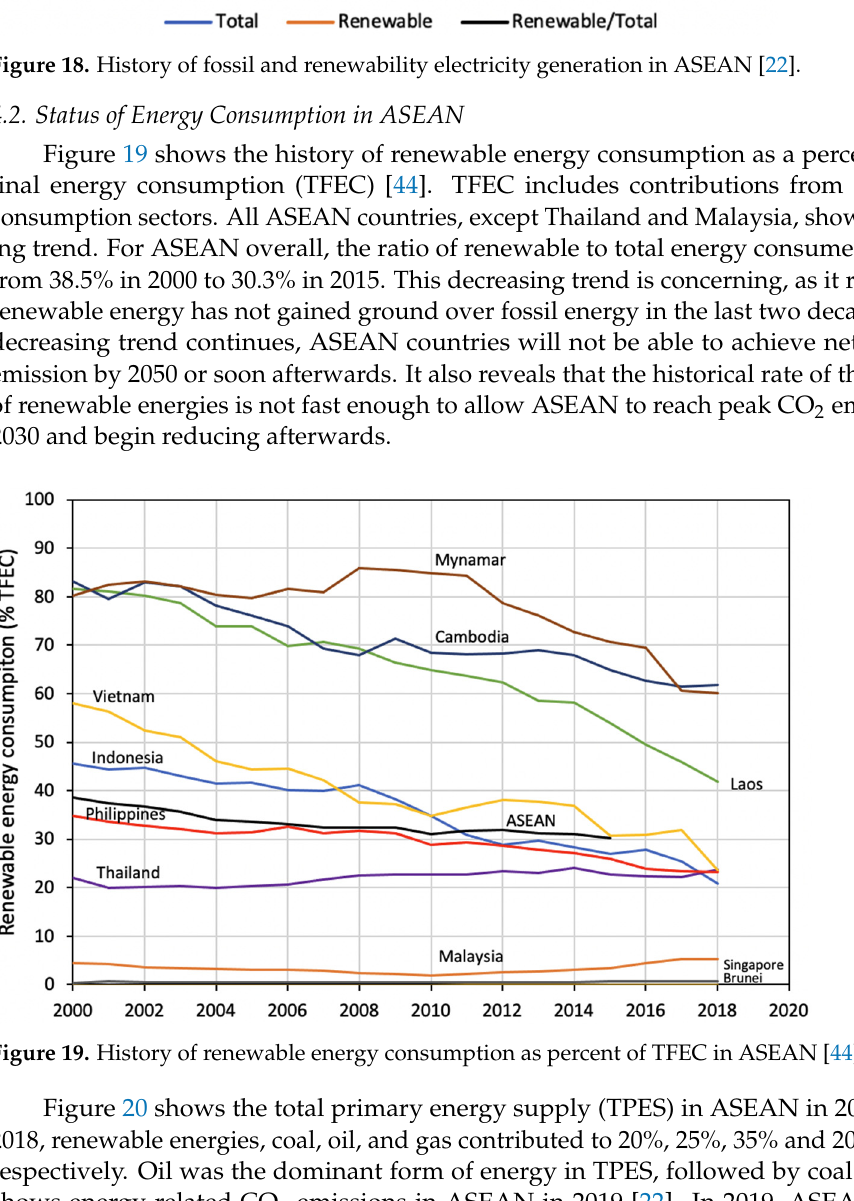
Figure 18. History of fossil and renewability electricity generation in ASEAN [22] .